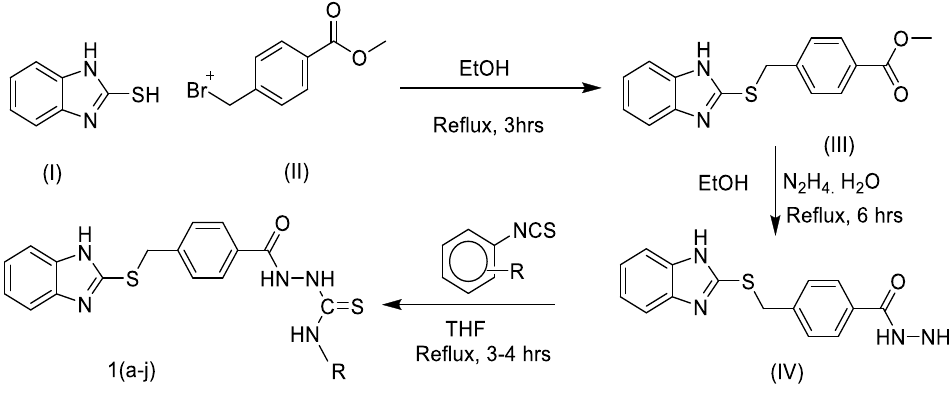
Table 1. Structure and acetylcholinesterase inhibition activities of benzimidazole thiosemicarbazide